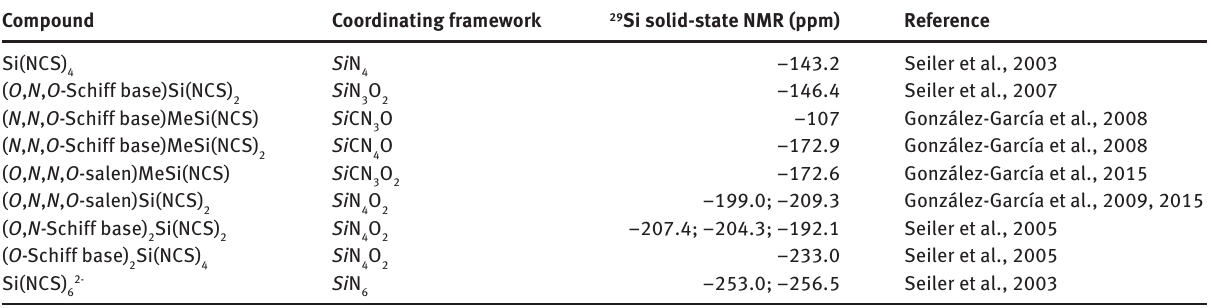
Chart 1: Selected examples of silicon compounds containing-NCS functionalities whose structure have been confirmed by a single-crystal X-ray diffraction Table 1: Selected examples of tetra-, penta-, and hexacoordinate silicon compounds containing-NCS functionalities showing the coordinating framework and 29 Si chemical shift.